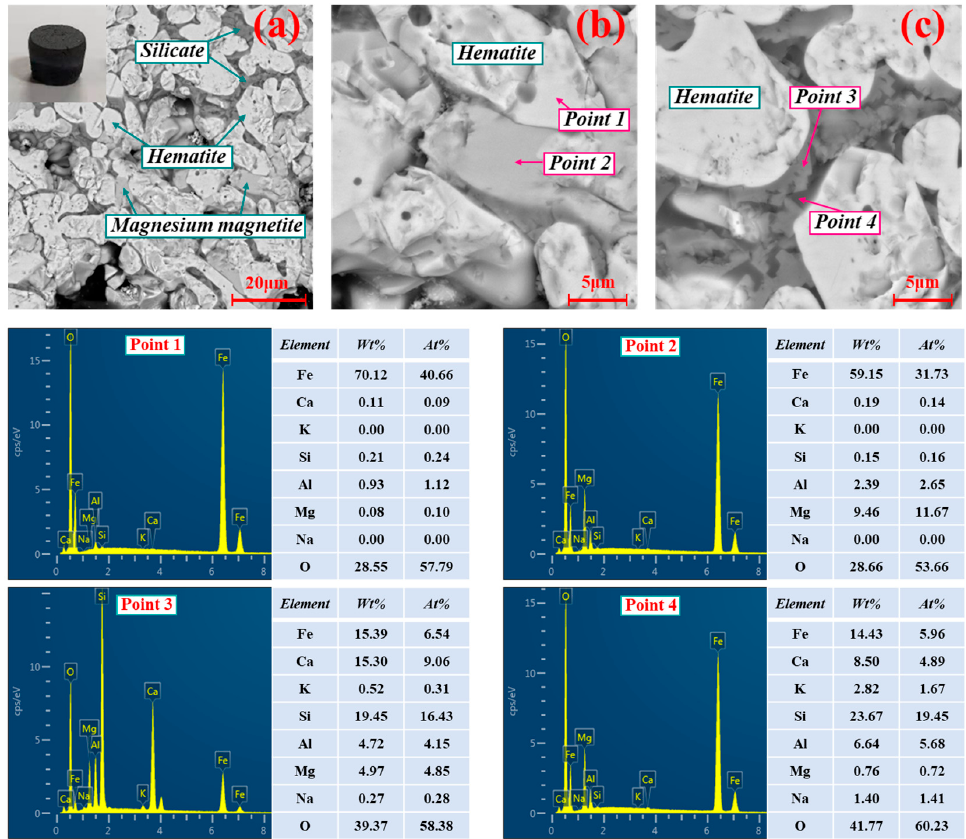
Figure 6. Scanning electron microscopy (SEM)–energy dispersive spectra (EDS) analysis of deposit simulant with 2 wt% MgO: ( a ) SEM MAG 2.00 kx; ( b ) and ( c ) SEM MAG 8.00 kx.